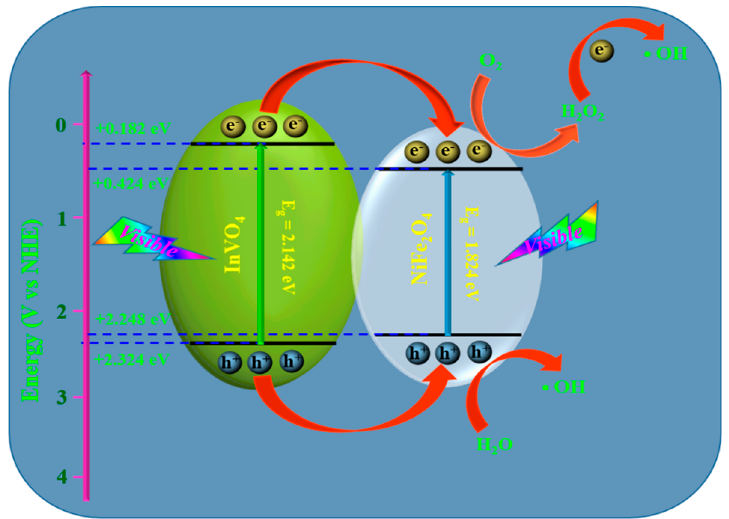
Figure 12. Photocatalytic degradation mechanism of TC molecules by the InVO 4 /NiFe 2 O 4 nanocom- posite under visible light.